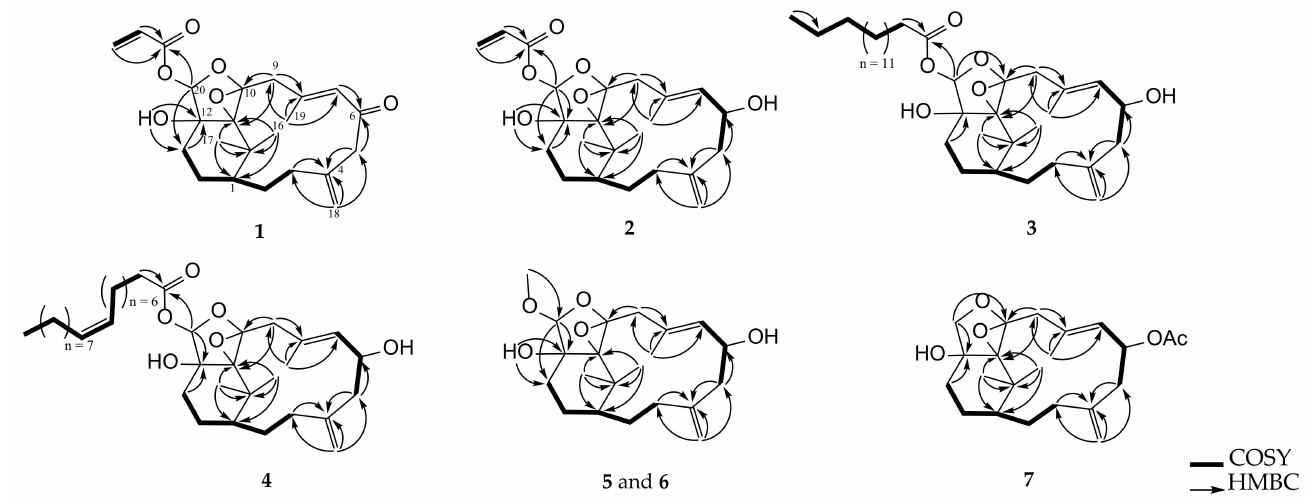
Figure 3. Selected COSY and HMBC correlations of 1 – 7